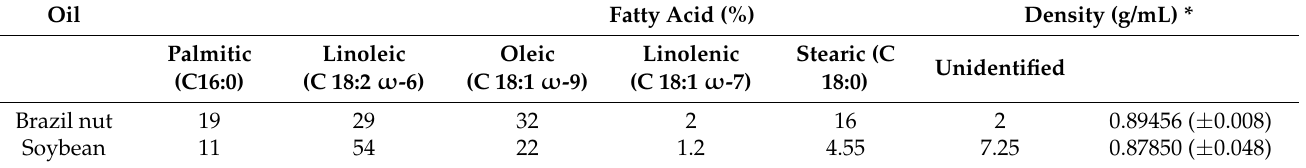
Table 1. Mean of fatty acid composition (%) and density of the vegetable oils (Brazil nut and soybean oils) used in the NLC